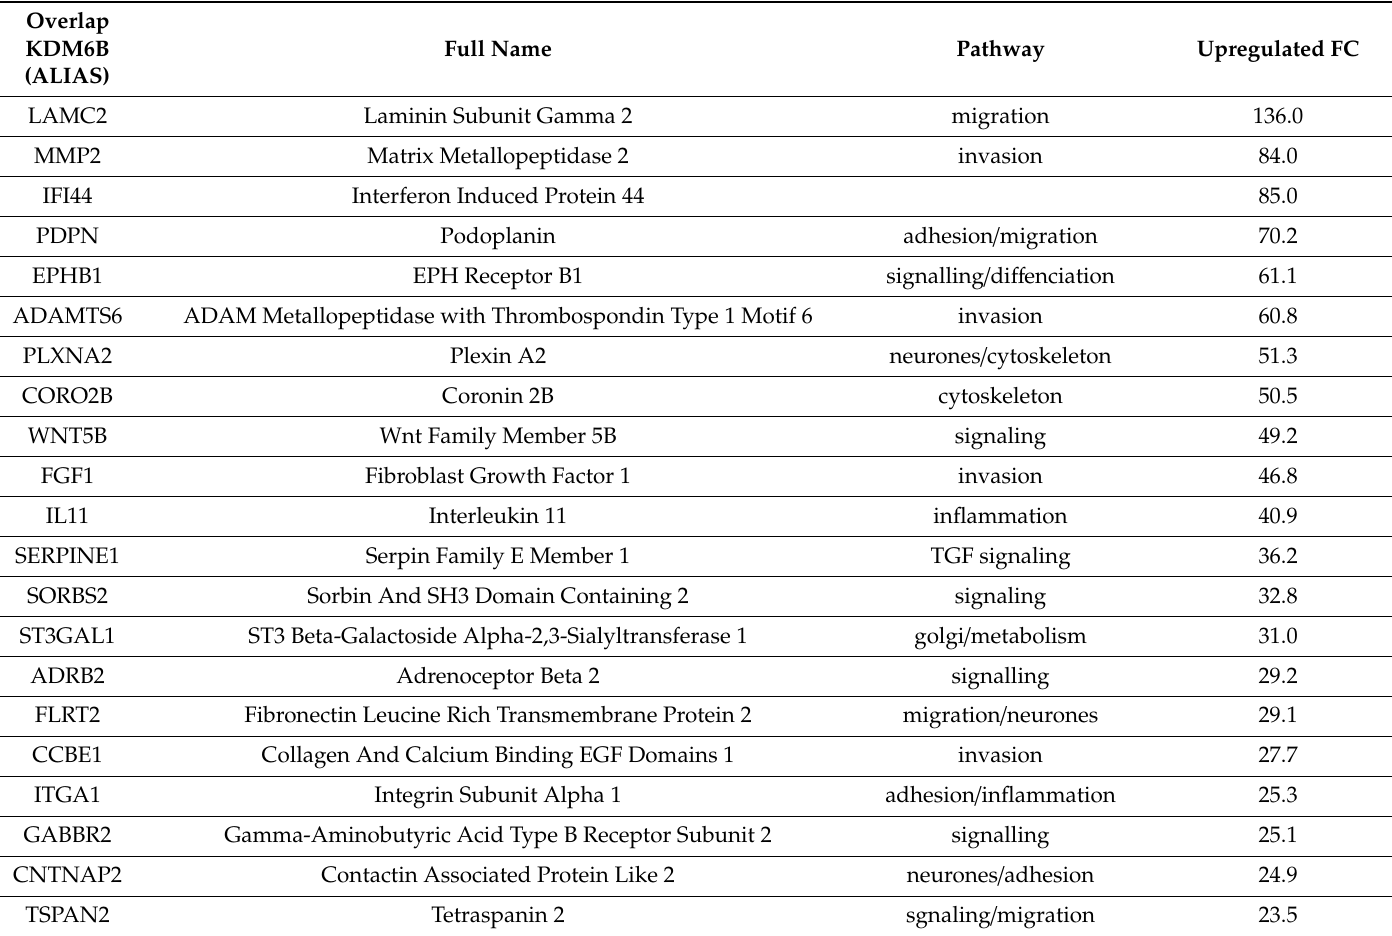
Table 2. A list of 40 most up-regulated genes in EMT and associated with KDM6B recruitment. Genes previously associated to EMT are